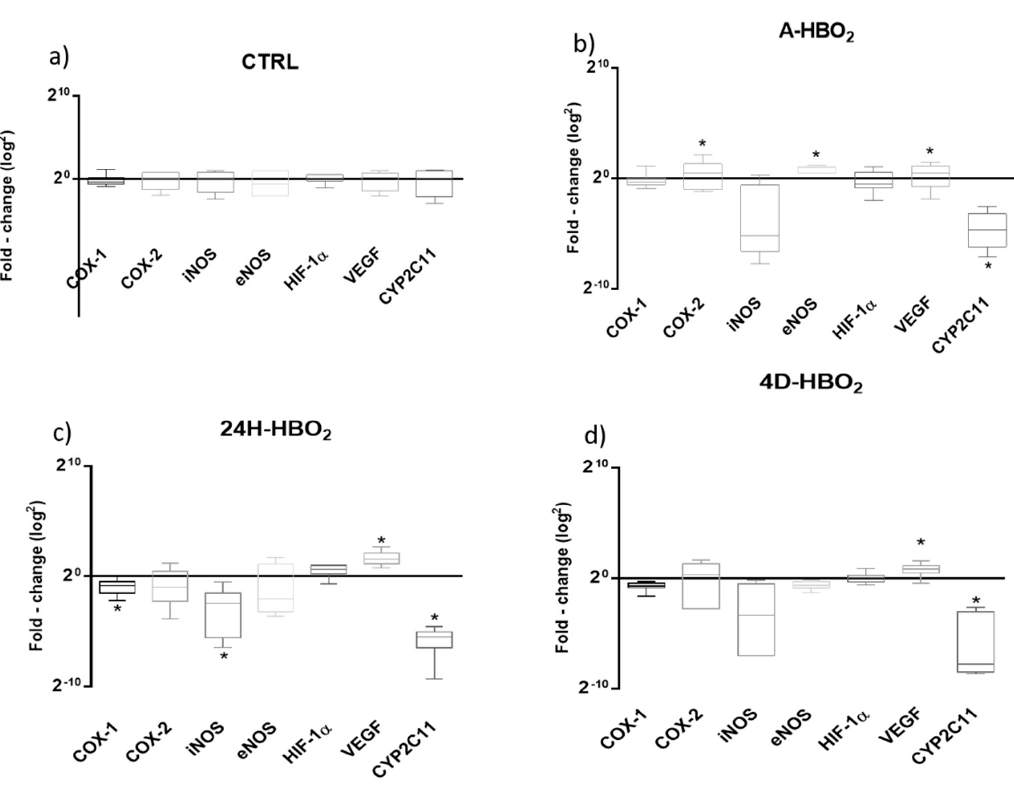
Figure 4. Expressions of COX-1, COX-2, iNOS, eNOS, HIF-1 α , VEGF and CYP2C11 in rat aorta in CTRL ( a ), A-HBO 2 ( b ), 24H-HBO 2 ( c ) and 4D-HBO 2 group ( d ). Results were normalized to HPRT housekeeping gene and control and presented using whisker bars as fold change (2 − ∆∆ CT ). * p < 0.05 was considered significant.